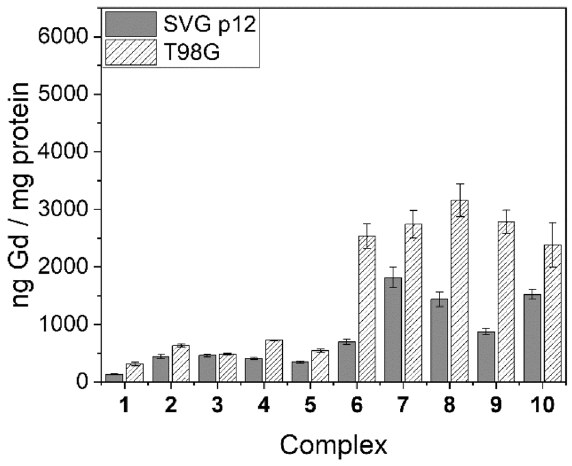
Figure 3. Cell uptake values for complexes 1 – 10 in SVG p12 and T98G cell lines at 125 μM.